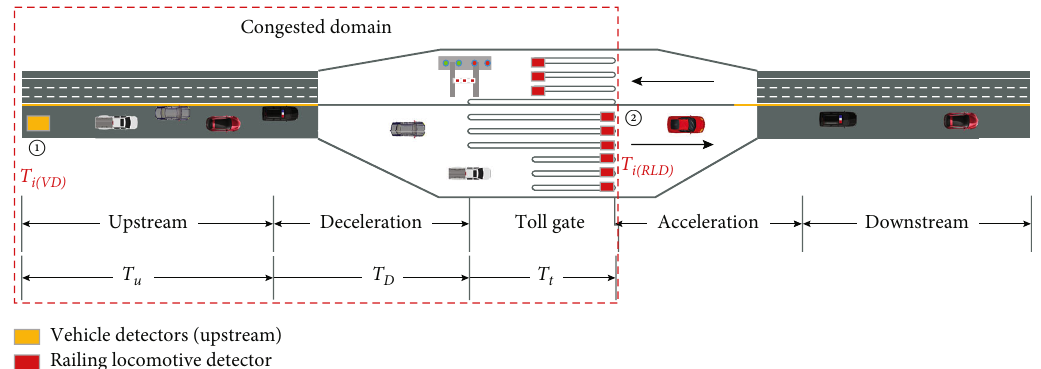
Figure 3: Composition of toll-gates and construction of congestion